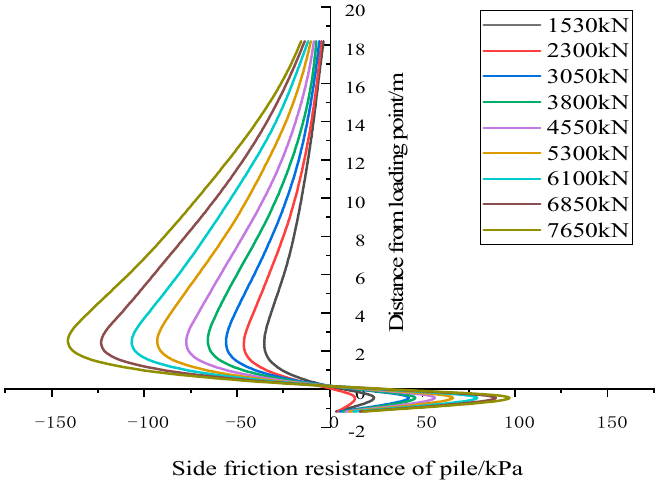
Figure 16. Distribution map of pile side friction under different loads.